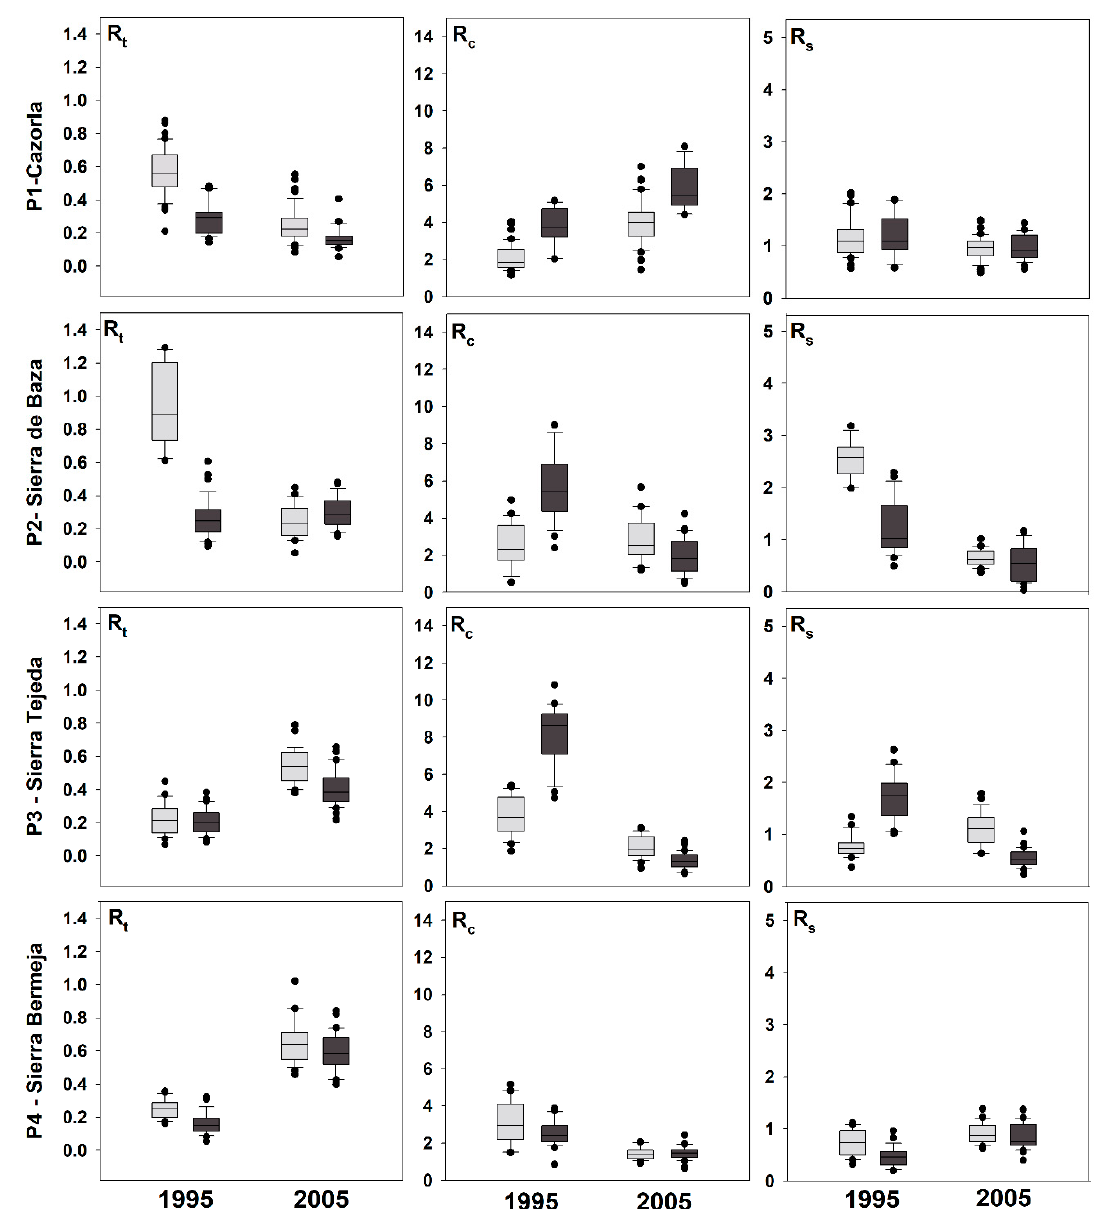
Figure 6. Response of the resistance (R t ), recovery (R c ), and resilience (R s ) growth indices calculated for the natural forest (grey bars) and plantations (black bars) of Pinus pinaster , considering four sampled sites and two droughts (1994–1995, 2005).